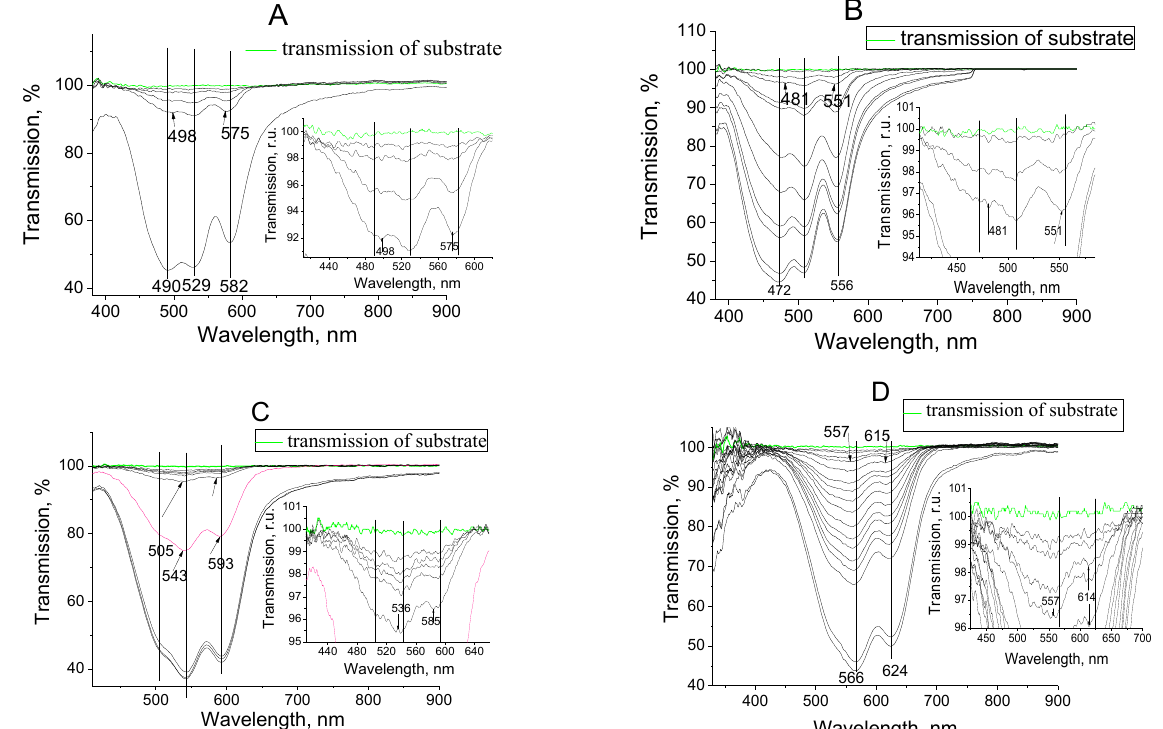
Figure 7. Absorption spectra of one-component dye films (I ( A ), II ( B ), III ( C ), IV ( D )) registered at the time of their formation (in situ) in a vacuum chamber with an interval from one to 100 s of deposition. The glass substrates were used.